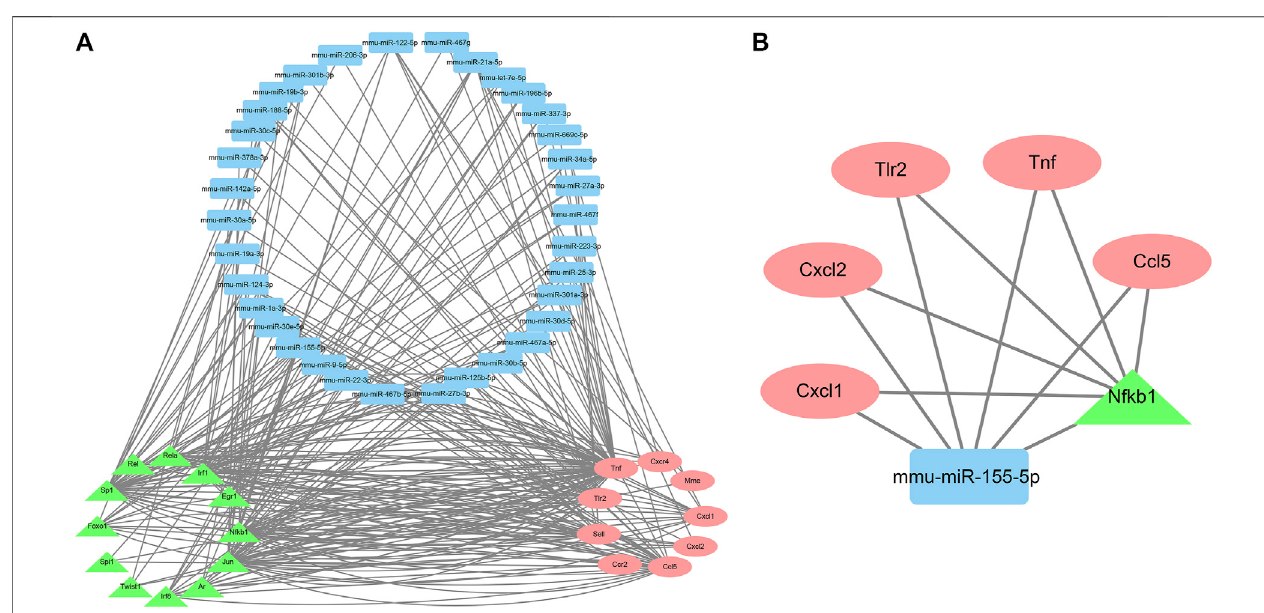
FIGURE7| TheTF-miRNAco-regulatory networks ofthe target genes.A. Co-regulatorynetworksconsisting ofnine genes, 12 TFs, and 34miRNAswithpairwise relationships. B. Co-regulatory networks consisting of mmu-miR-155-5p and Nfkb1.